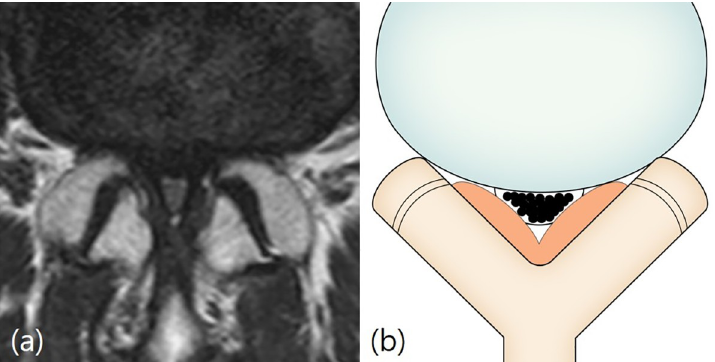
Fig 6. Lee classification. Grade 3 (severe stenosis). Fig 6A and 6B: A 69-year-old woman with pain in both lower extremities. T2-weighted axial magnetic resonance image at L4/5 disc level shows severe obliteration of the anterior cerebrospinal fluid space, marked compression of the dural sac, and the entire cauda equina appearing as one bundle.